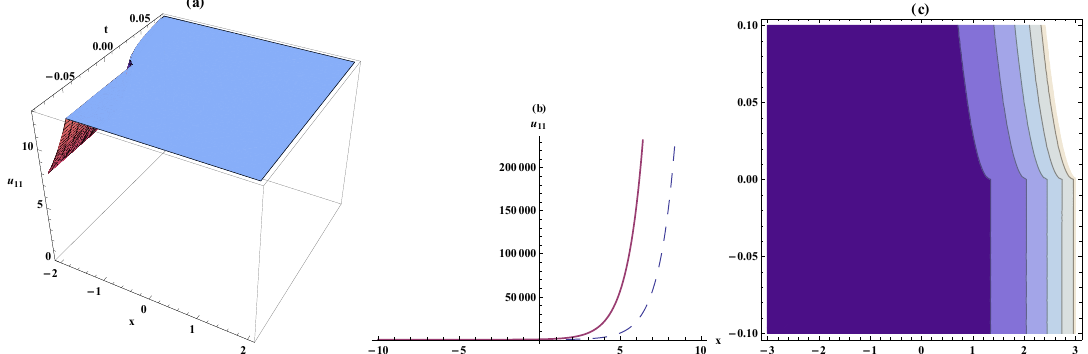
Figure 1. Bright solitary wave, the bistable wave amplitude, and contour plots for Equation (5). On the respective interval { x , − 2.05,2.05 } , { t , − 0.08,0.08 } , { x , − 10,10 } , { t , − 1,1 } , { x , − 3,3 } , { t , − 0.1,0.1 }